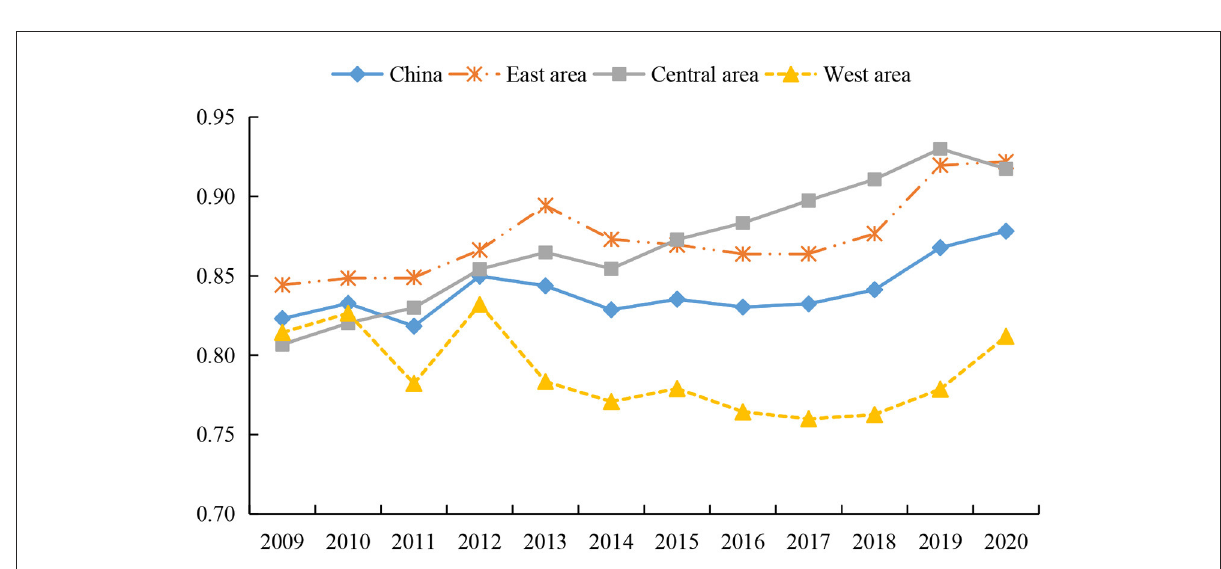
FIGURE4 Trends of service operation efficiency of health systems in different regions from 2009 to